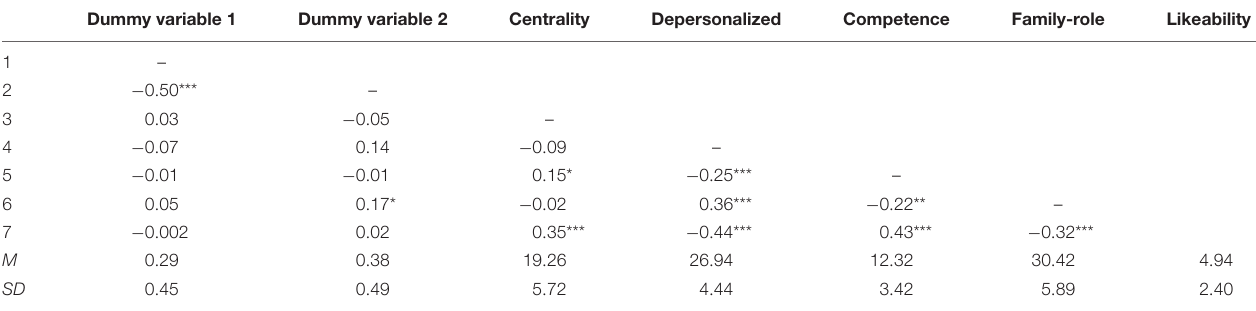
TABLE 2 | Correlations, means, and standard deviations for all study variables in Experimental 2. Dummy variable